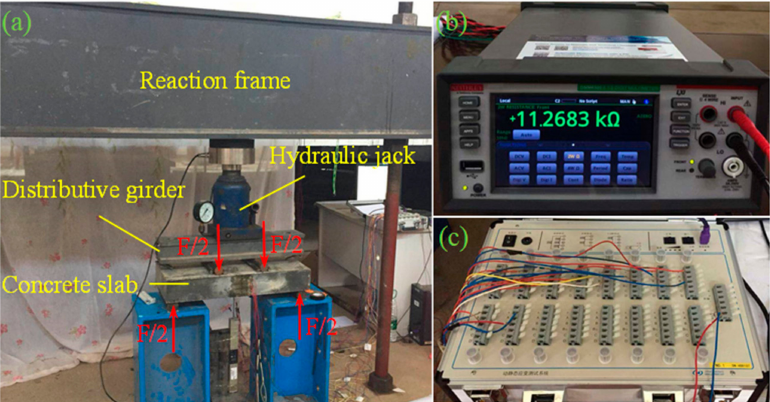
Figure 10. Layout of the experimental setup: ( a ) four-point loading chart; ( b ) source meter; ( c ) static resistance strain